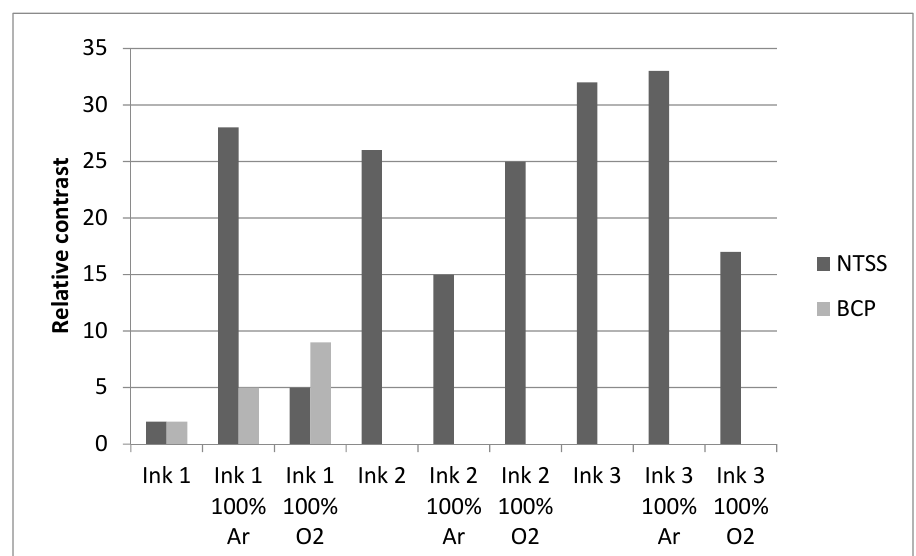
Figure 3. Changes in relative contrast of prints as a function of ink kind, substrate and kind of plasma activation.